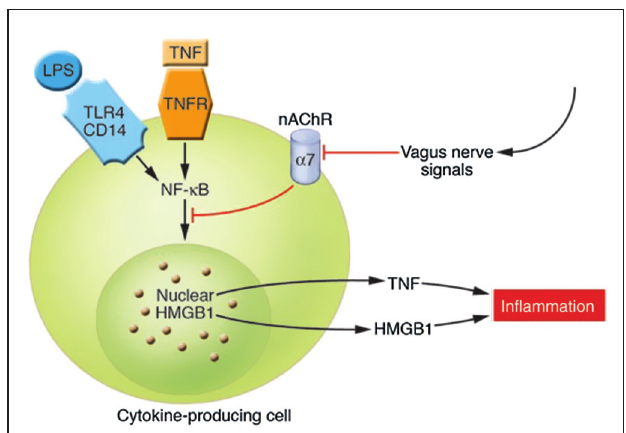
FIGURE 4 | The set point function of the immune response is defined by the magnitude of innate immune responses relative to the infection or injury stimulus . Increasing the set point or shifting the curve to the left increases the chance that tissue damage will occur from the response to infection or injury. Decreasing the set point or shifting the curve to the right reduces the probability that tissue damage will occur. CAP is the neural circuit that provides acute compensatory input to adjust the magnitude of the immune response relative to the set point (With permission from Nature Publishing Group) (Tracey,